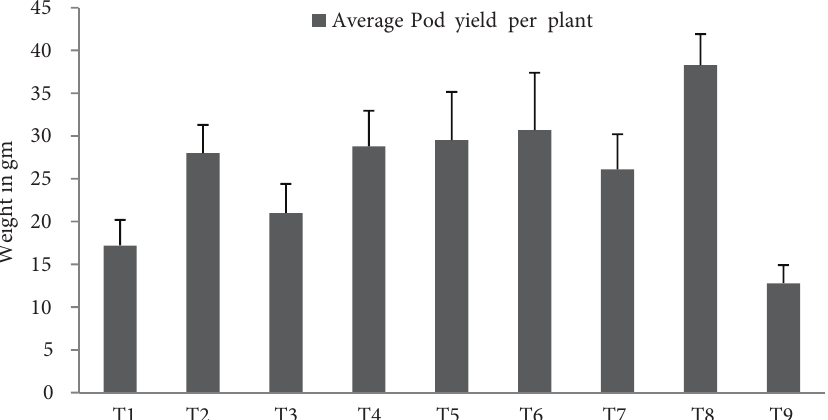
Figure 5. Effect of rhizobacteria on average biomass per host plant in field